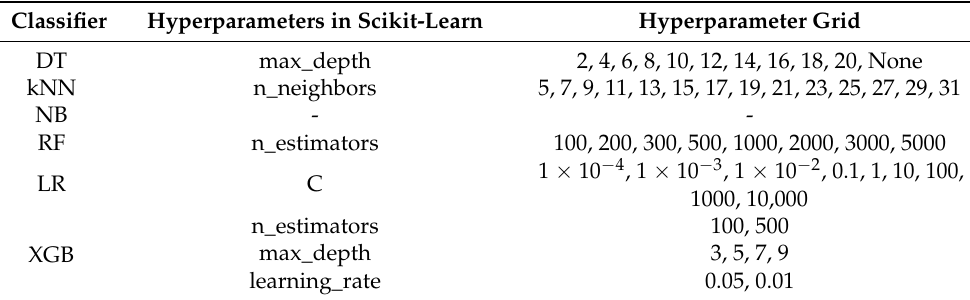
Table 4. Hyperparameters. DT, decision tree; kNN, k-nearest neighbor; NB, naïve Bayes; RF, random forest; LR, logistic regression; XGB: XGBoost. In the naïve Bayes (NB) classifier, no hyperparameter was used.